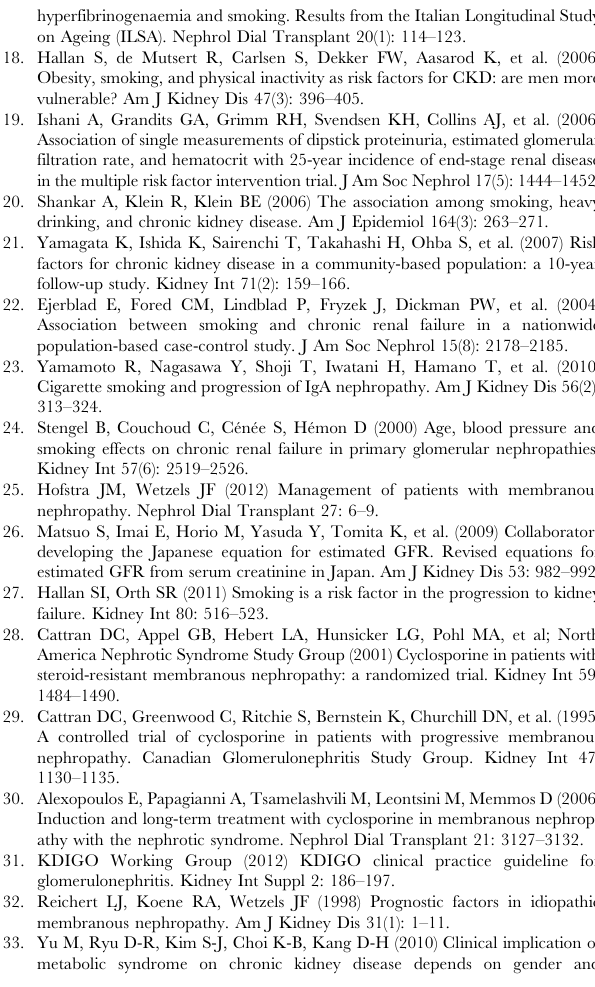
Table S1 Predictors of a 50% decline in eGFR.